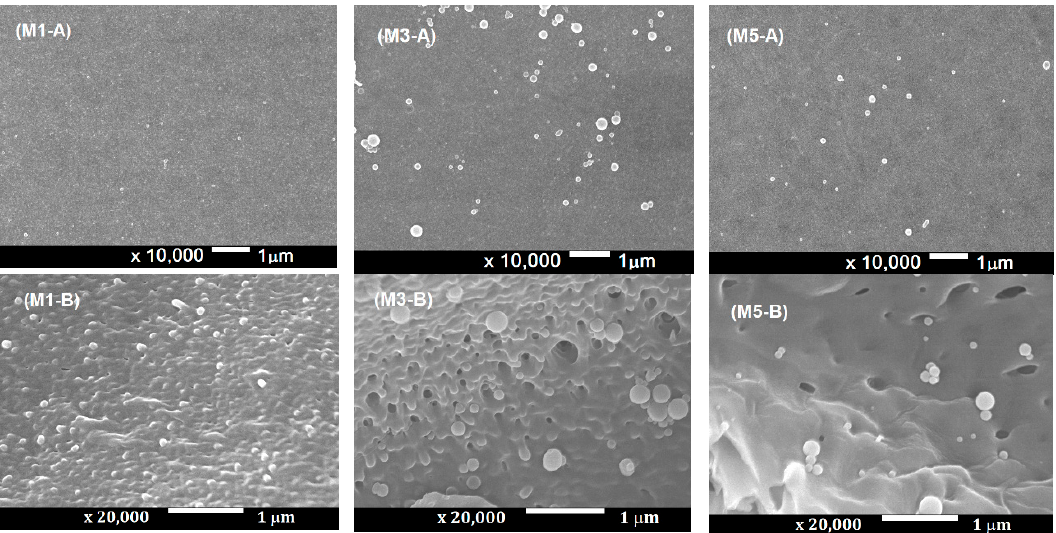
Figure 1. SEM imaging of the ( A ) surface and ( B ) macrovoid structure of the M1, M3, and M5 membranes. Figure1. SEMimagingofthe( A )surfaceand( B )macrovoidstructureoftheM1, M3,